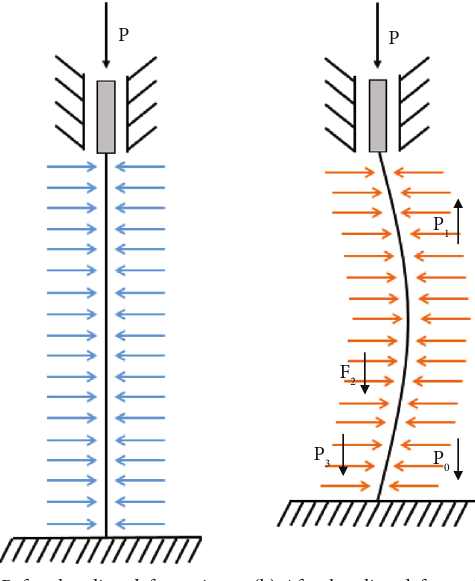
Figure 5: Schematic diagram of bending deformation of casing.